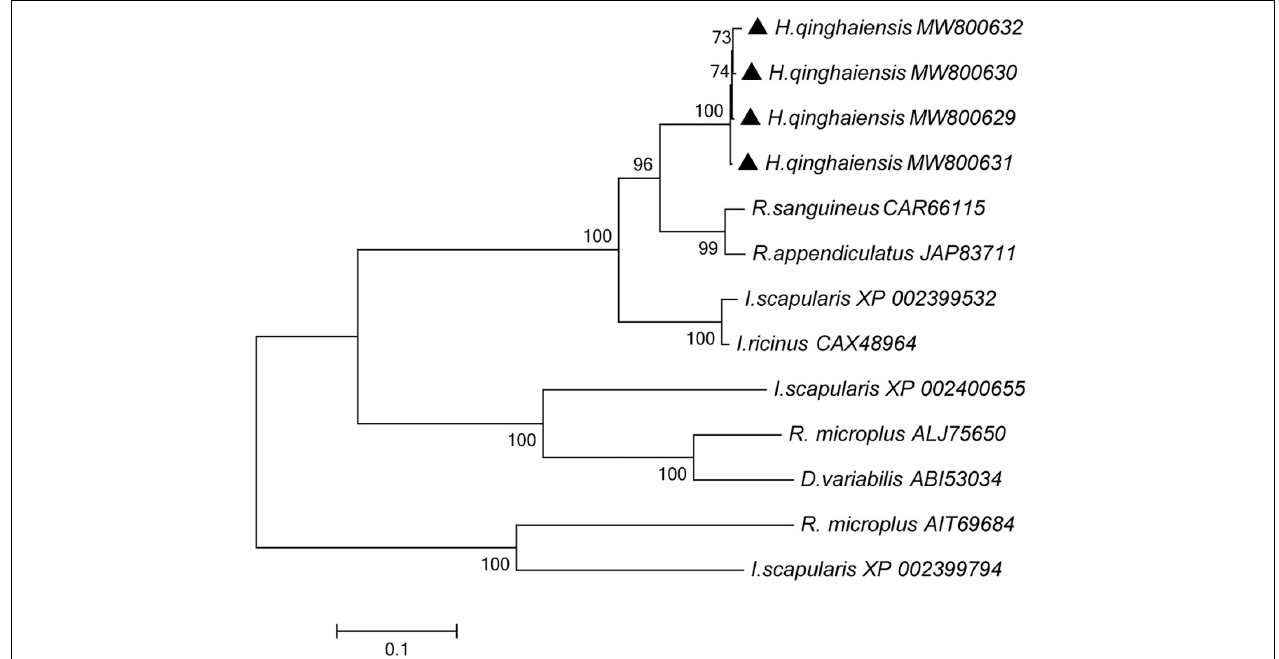
FIGURE 5 | Phylogenetic tree of the amino acid sequences of H. qinghaiensis AQP1 transcript variants and of all known members of the AQP in R. sanguineus , R. appendiculatus , R. microplus, I. scapularis , I. ricinus , and D. variabilis. The accession numbers were showed after parasite species name. The HqAQP1 sequences obtained in this study were indicated with bold triangle. The analysis involved 12 amino acid sequences. The tree was inferred using the neighbor-joining method of MEGA7 · 0 · 18; bootstrap values are shown at each branch point. Numbers above the branch demonstrate bootstrap support from 1,000 replications. All sites of the alignment contained insertions and deletions; missing data were eliminated from the analysis (option “complete deletion”). The optimal tree with the sum of branch length = 3.64528684. The evolutionary distances were computed using the p -distance method and are in the units of the number of amino acid differences per